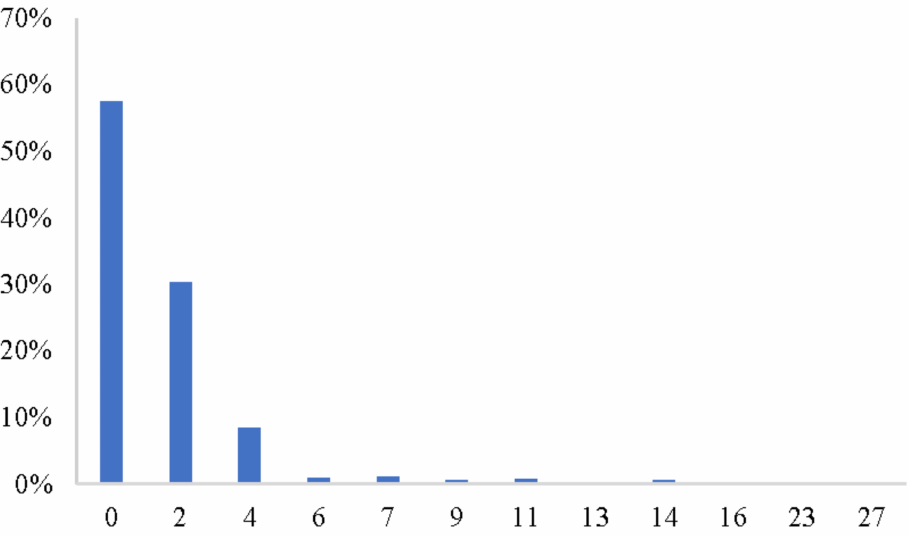
Figure 6. The scale change of food reserves before the COVID-19 and survey